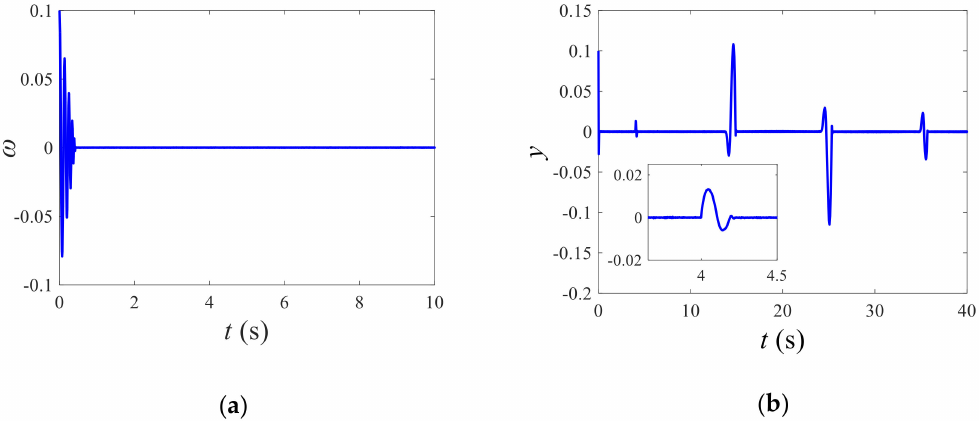
Figure 7. State trajectories of the HTGS under multiple faults with the proposed fault-tolerant controller (Equation (62)). ( a ) ω ( t ) − t ; ( b ) y ( t ) − t